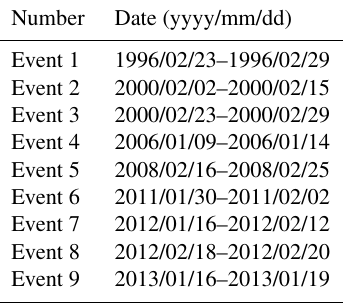
Table 1. A list of cold events during